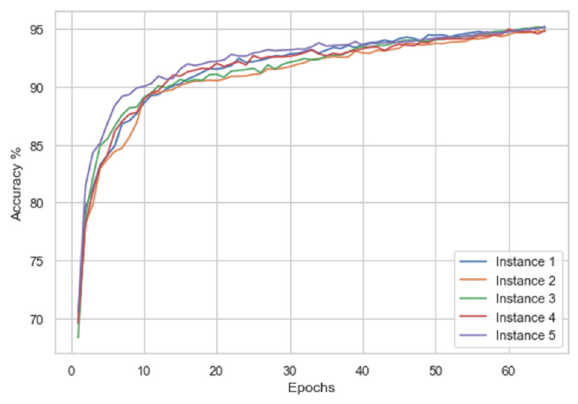
Figure 11. Accuracy for the five instances.